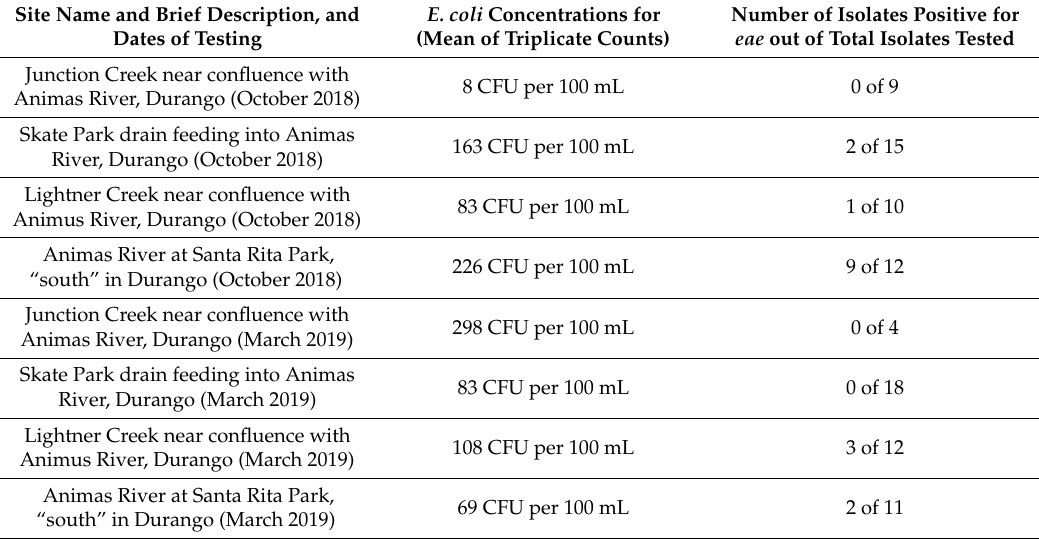
Table 4. Animas River watershed testing conducted during 2018–2019: PCR test results for eae